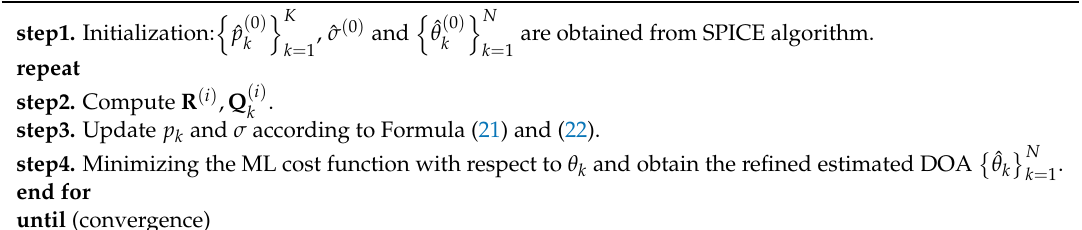
Table 1. The SPICE-ML